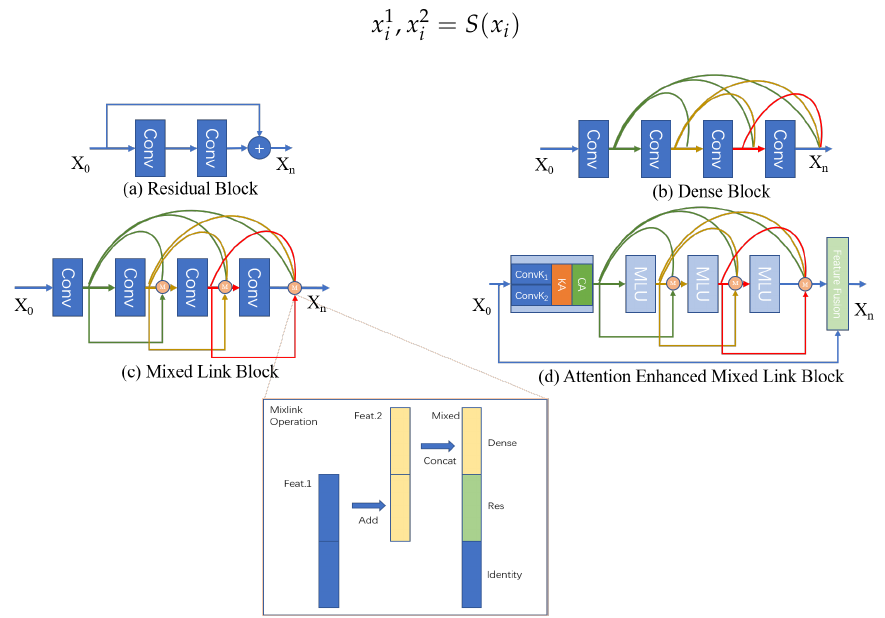
Figure 2. Comparison of different network structures. ( a ) residual block in ResNet, ( b ) dense block in DenseNet, ( c ) mixed-link block with a topology fusion of residual block and dense block, ( d ) attention-enhanced mixed-link block. Feat1 and Feat2 are features from current and previous convolution layers. Polyline denotes the residual (skip) connection and the curve denotes dense (concatenate)